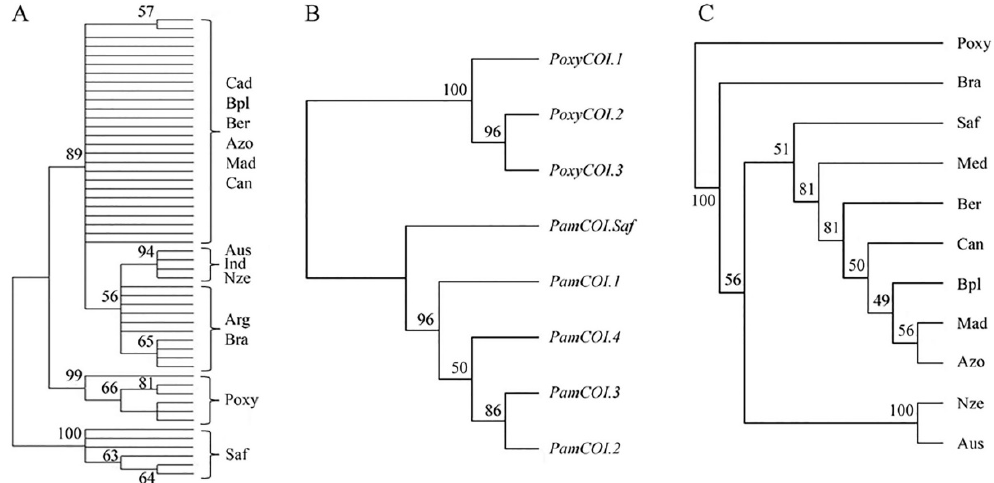
Figure 3. ( A ) Maximum likelihood phylogenetic tree on COI sequences (log-likelihood − 1109.4004) implemented with the HKY+G model of substitution. The percentage of trees in which the associated taxa clustered together is shown next to the nodes. Bootstrap values less than 50% are not shown; ( B ) Neighbor-joining dendrogram built with eight COI haplotypes from P. americanus and P. oxygeneios . Percentages of trees with the same clustering out of 10,000 resampled trees are shown on nodes. Bootstrap values less than 50% are not shown; ( C ) Neighbor-joining dendrogram based on the chord distance from the allele frequencies of microsatellites. Percentages of trees with the same clustering out of 10,000 resampled trees are shown on nodes.